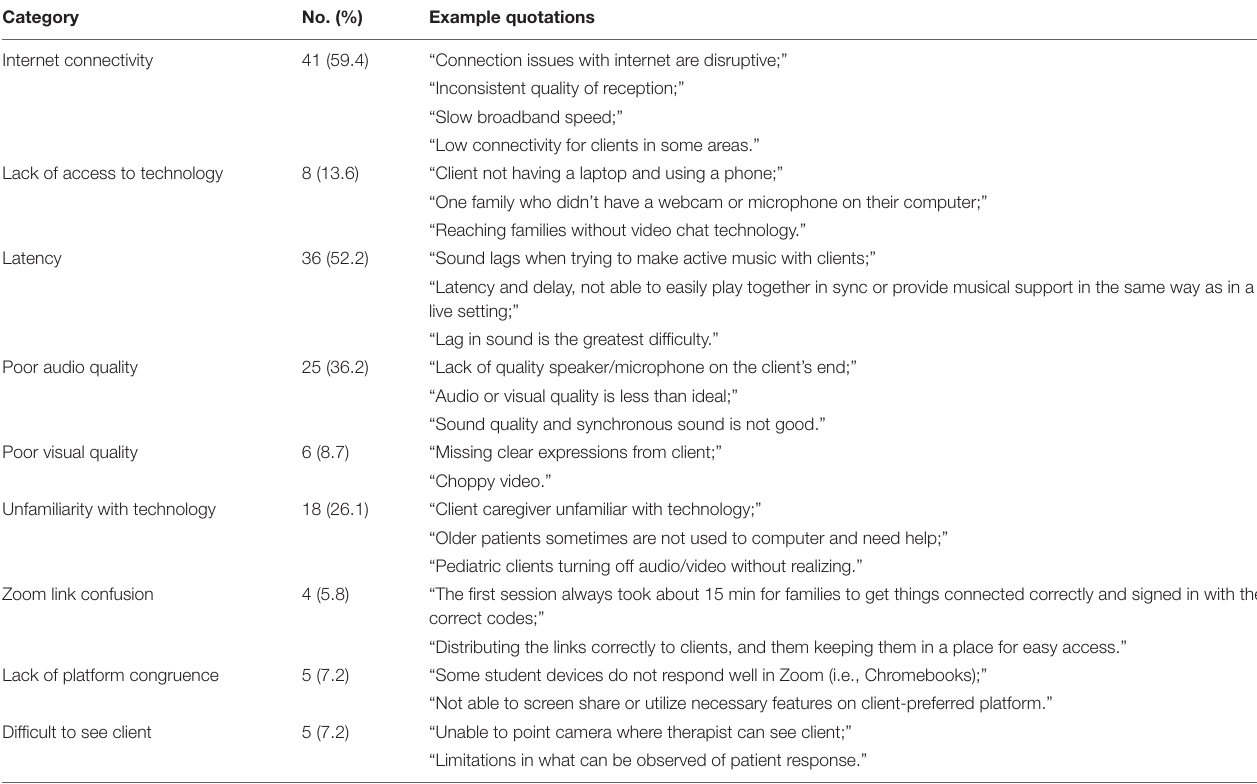
TABLE 9 | Technology